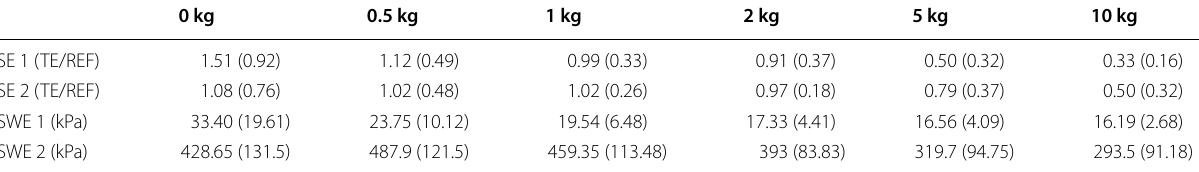
Table 1 Median (IQR) of the strain ratio (tendon/reference material) and Young’s modulus (kPa) at different contraction